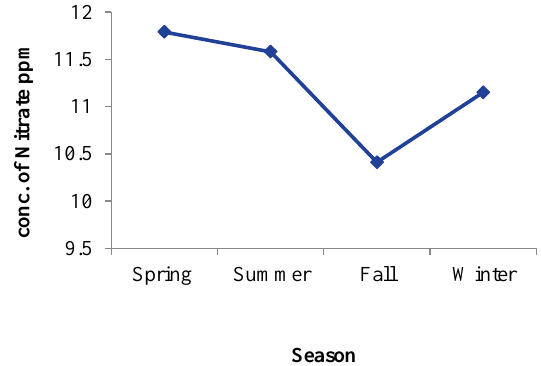
Iron The results indicated that the average iron in the studied areas was 0.1361 mg/l with a standard deviation of 0.089.